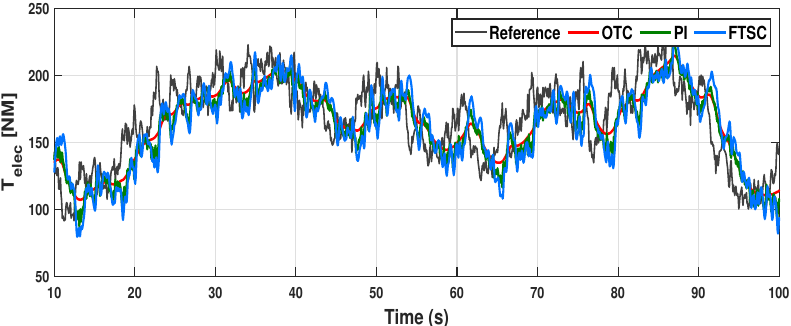
Figure 15. Comparative analysis of T elec under the control schemes discussed for varying wind profile case-I